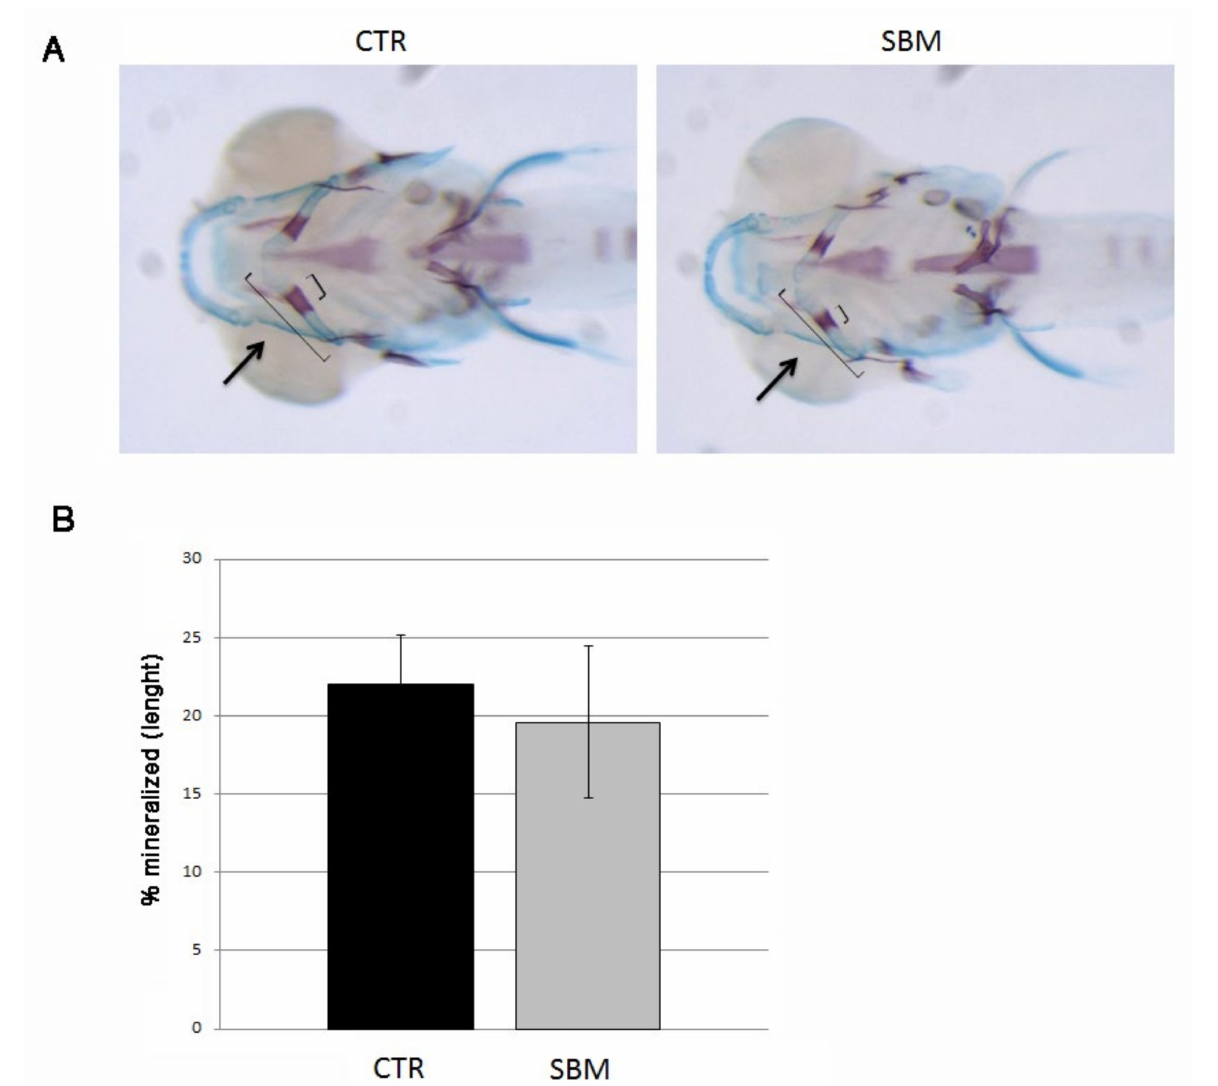
Figure 3. Bottom view of zebrafish larvae head double stained with alizarin red and alcian blue. ( A ) Mineralizing cartilage structures of CTR and SBM embryos can be visualized in purple, black arrow indicates the mineralizing area of cerathoyal. ( B ) Percentage of cerathoyal mineralization (small square bracket in A ) compared to total length of jaw (long square bracket in A ) in CTR and SBM larvae. Data derived from 10 CTR and 10 SBM larvae, with tests performed 3 times as independent experiments with comparable results. No significant difference was detected using the Student t